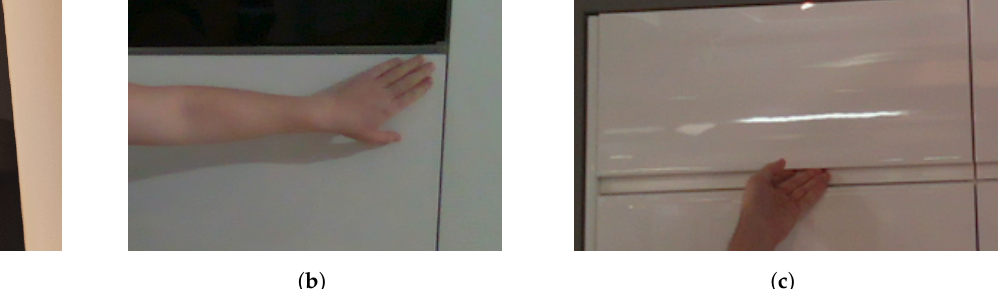
Figure 1. Opening doors without handles. ( a ) A push mechanism. ( b ) An example of opening of the push mechanism door. ( c ) An example of opening of the door with hidden